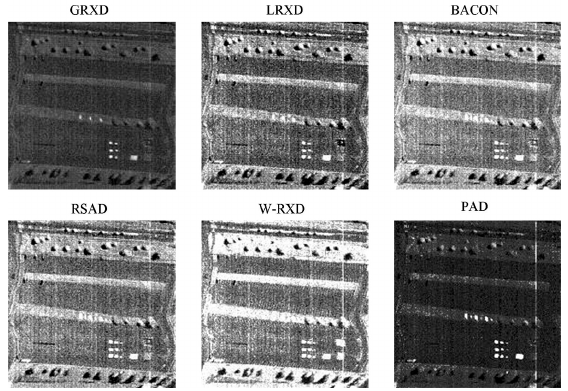
Figure 5. Detection results produced by different algorithms with the SpecTIR data.